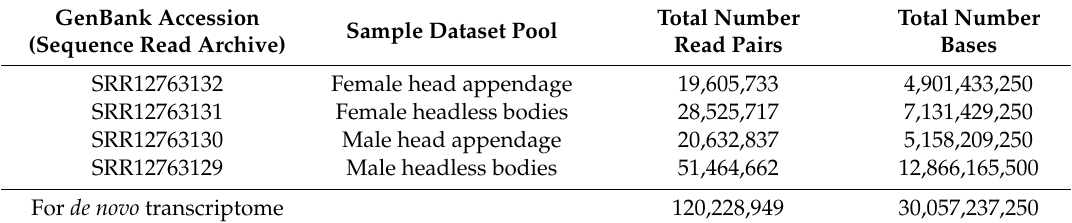
Table 1. Summary of transcriptome data from horn fly head appendages and headless